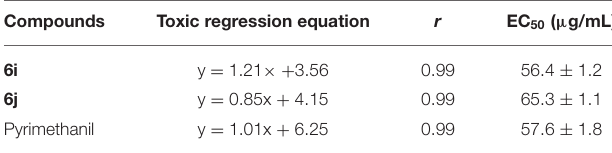
TABLE 2 | The EC 50 values of compounds 6i and 6j against B. dothidea